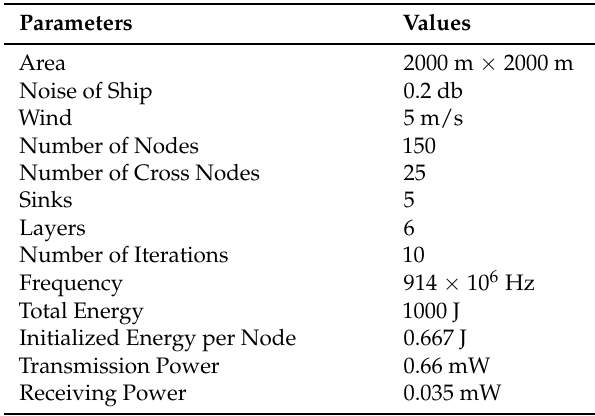
Table 4. Simulation